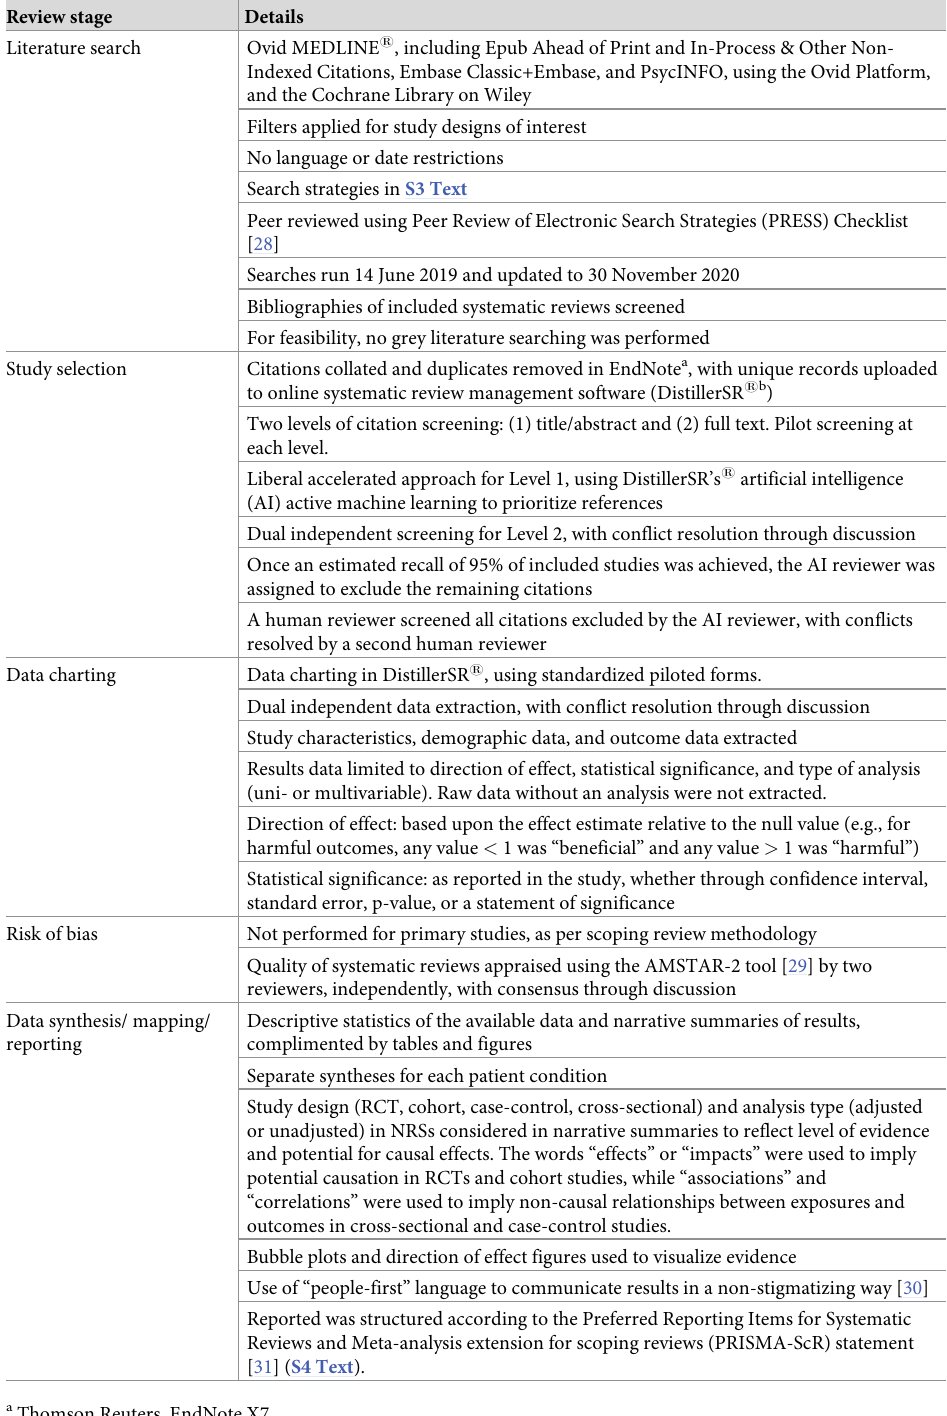
Table 2. Methods in